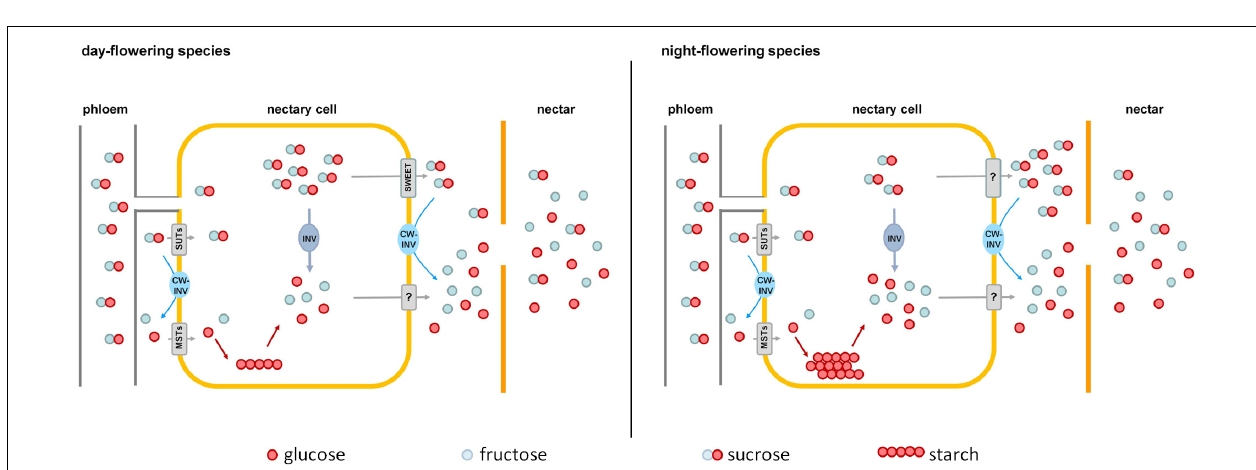
FIGURE 7 | Post-secretional changes in sugar content in the nectar All samples were analyzed immediately after collection, as well as 12, 24, and 48 h after collection; n = 3.